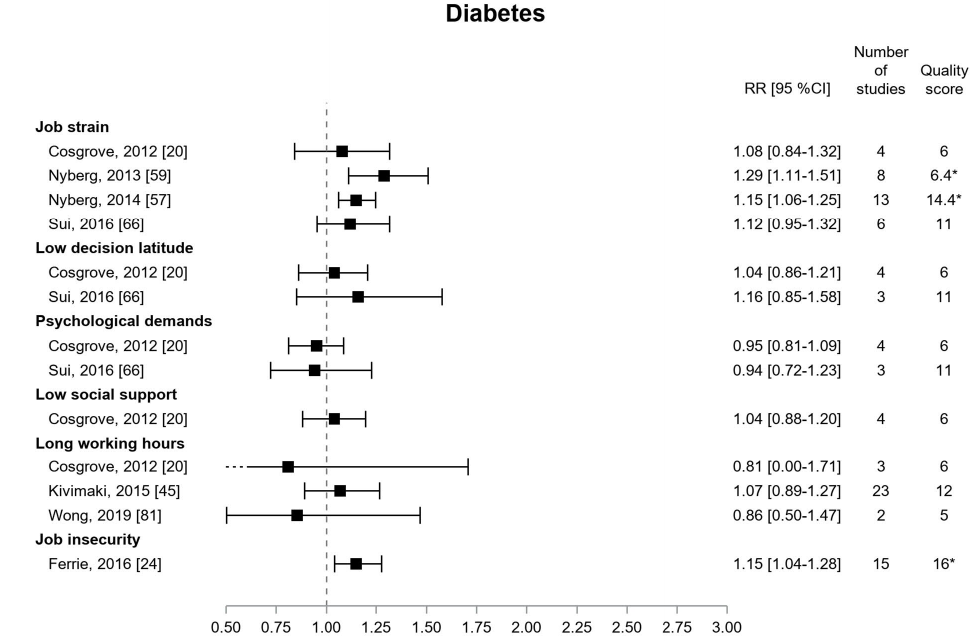
Figure 4. Pooled estimates for the associations between psychosocial work exposures and diabetes. * IPD-Work Consortium studies without systematic literature review.